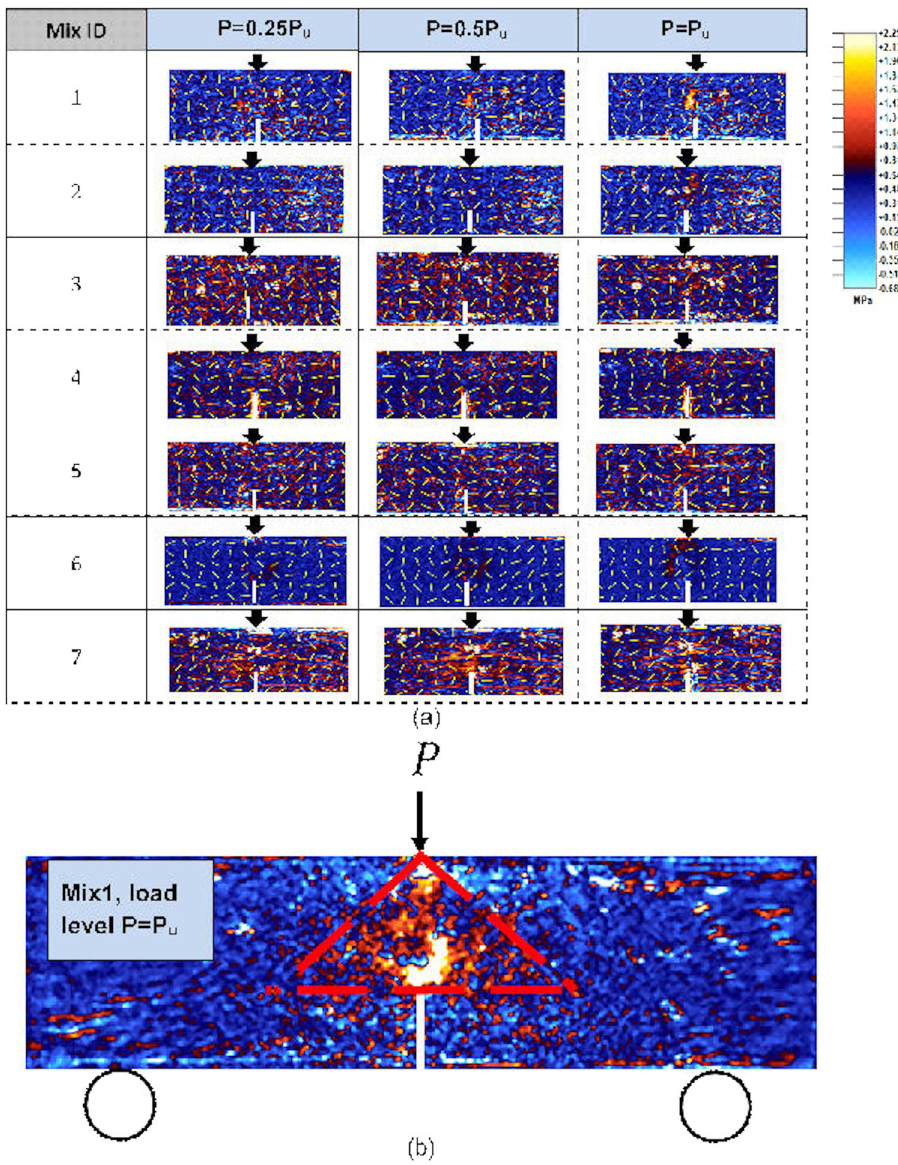
Figure 2. Maximum shear stress distribution on the concrete samples under different loading levels P. Pu is the ultimate load (strength) of the beam: ( a ) presented for the mid one-third region of the beams subjected to 28 days curing for comparison purposes. The arrows show the direction of the major principal stress and ( b ) a typical image for the whole beam subjected to 90 days curing. The triangular guidelines contain the region where maximum shear stress distribution is stronger (ahead of the notch) under the ultimate load. Plots similar to part ( a ) for all the mixes subjected to 90 days curing is provided in the supplementary